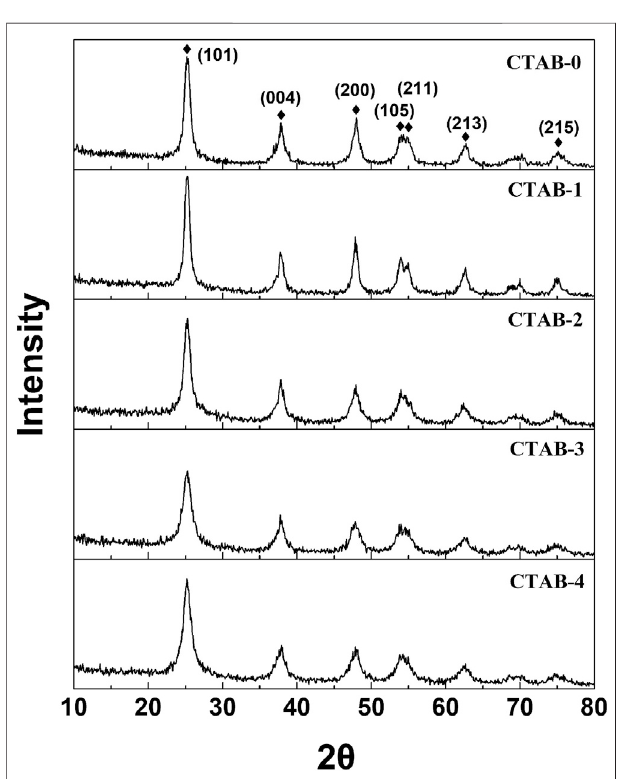
FIGURE 2 | XRD spectra of fi ve TiO 2